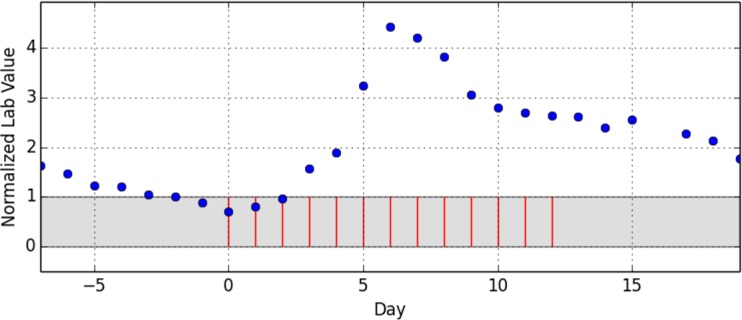
Example of extracted drug administration days (red bars) with corresponding normalized lab values (blue dots).A complete episode consist of a starting administration-free interval of seven days with at least five lab value observations, a period of continuous administration (max. one administration-free day) with at least five lab value observations and finally another administration-free interval of seven days with at least five lab value observations.